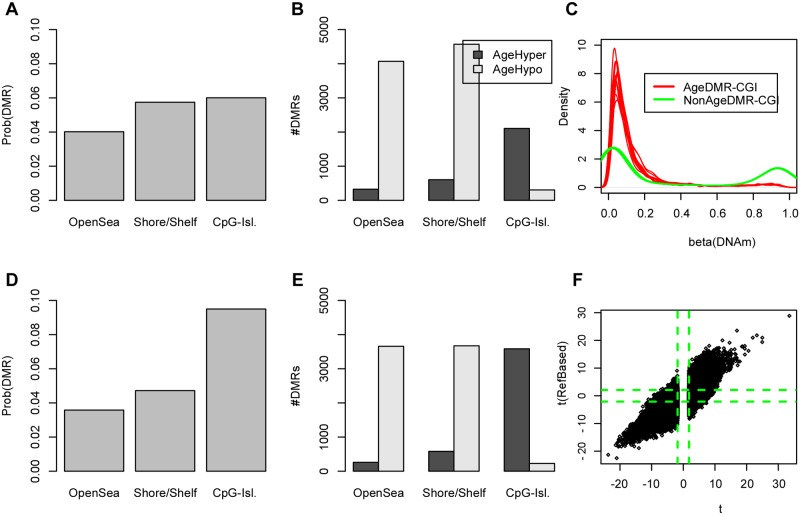
Age-DMRs are mostly enriched for CGIs and the enrichment of age-hypermethylated CGIs increases after adjustment for changes in blood cell subtype composition.
A) Probabilities that a randomly picked open-sea, shore/shelf and CpG-island region is an age-DMR (defined as the top 5% of DMRs). B) Relative numbers of age-hypermethylated and age-hypomethylated DMRs within each regional class. C) Focusing on CpG-islands, density plots of beta DNAm values of 2500 age-DMRs (red) vs. 2500 non-age associated DMRs (green) (P > 0.8). D) As A) but now for age-DMRs derived using the reference-based method of Houseman et al, which adjusts for putative changes in blood cell subtype proportions. E) As B), but now for the adjusted analysis. F) Scatterplot of the t-statistics of age-DMRs (defined here as those with FDR < 0.05 in the unadjusted analysis) (x-axis) against their corresponding t-statistics from the reference-based adjusted analysis (t(RefBased), y-axis). Green dashed lines indicate the lines of significance at FDR < 0.05.